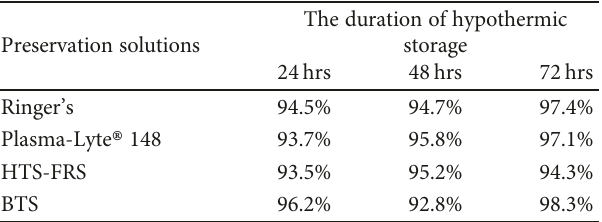
Figure 2: (a) Recovery of MSCs after hypothermic storage in di ff erent solutions and following recultivation for 1 and 4 days (alamarBlue assay). (b) Phase-contrast microscopy of MSCs after cold storage and 24hrs of recultivation. ∗ Values are signi fi cantly higher compared to Ringer ’ s solution ( p < 0 05 ); # values are signi fi cantly higher compared to Plasma-Lyte® 148 solution ( p < 0 05 ); & values are signi fi cantly di ff erent compared to the same group after 72 hrs of storage ( p < 0 05 ). Table 1: The percentage of cells with the immunophenotype CD105+/CD90+/CD73+/CD34-/CD45-/CD19-/CD14-/HLA-DR- after hypothermic storage in di ff erent preservation